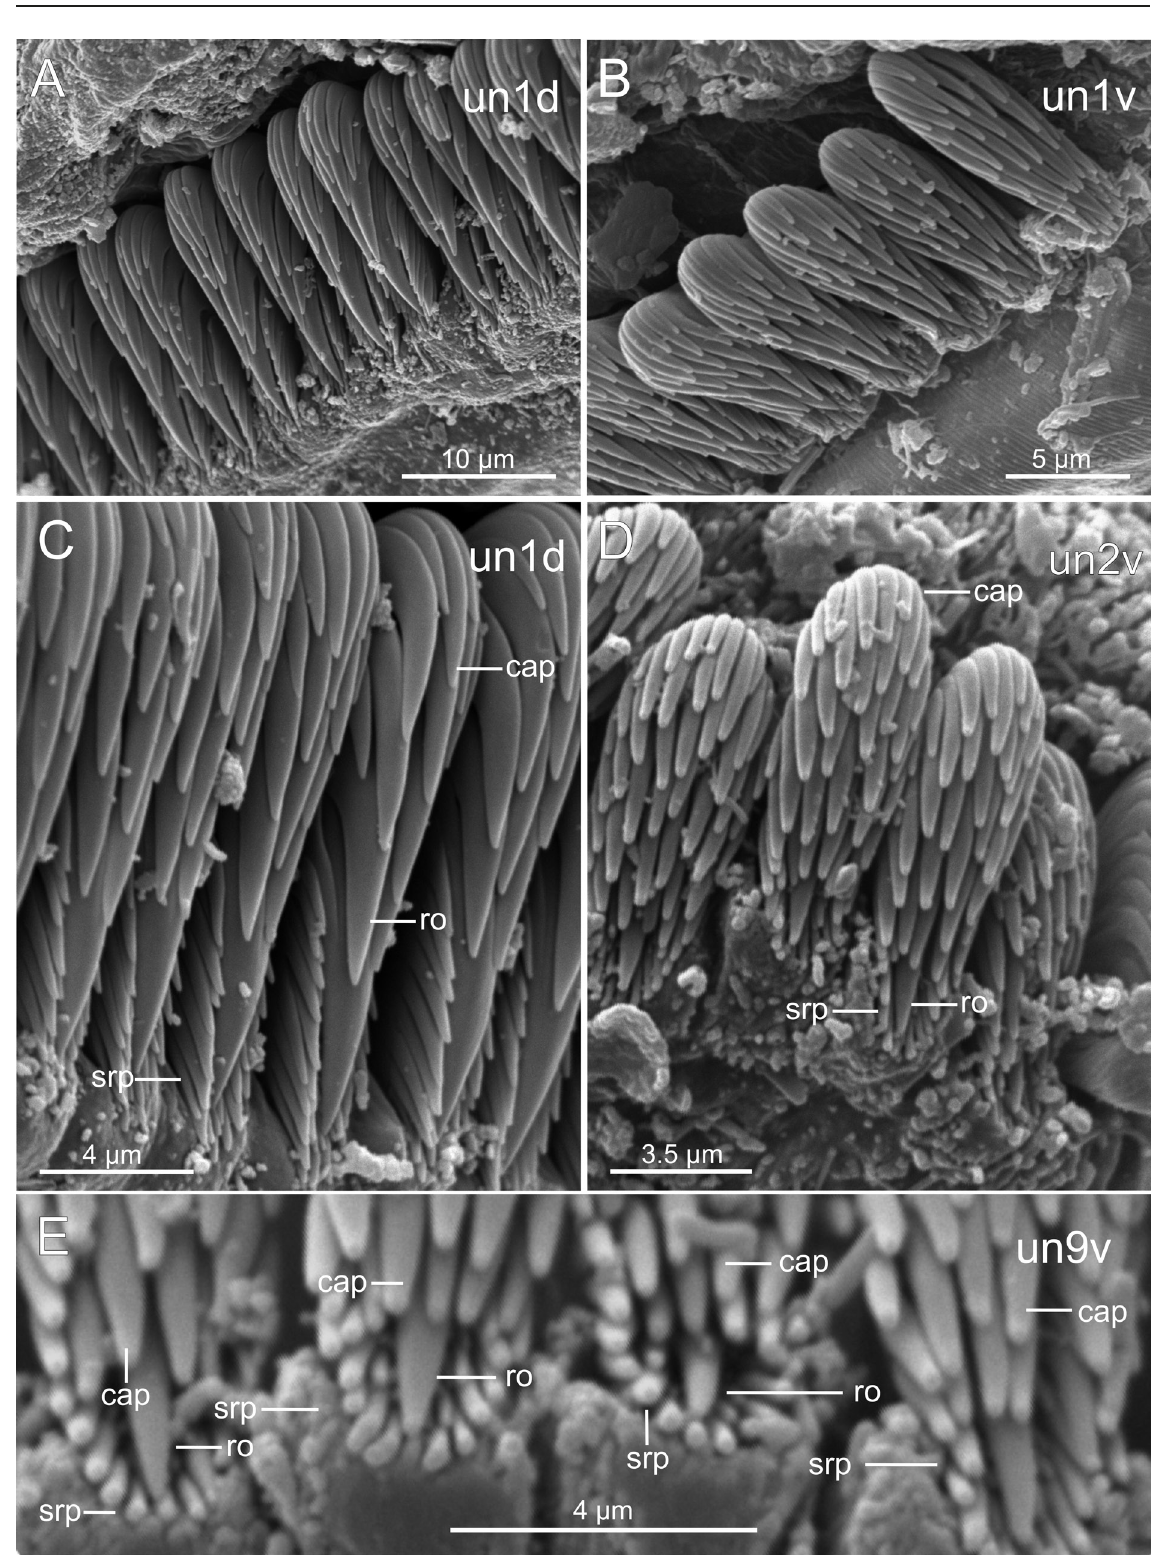
Fig. 7. Amphictene auricoma (O.F. Müller, 1776). SEM micrographs from a small specimen (BIOICE sample 2463, IINH-40481). A–B . Unciniger 1, dorsal and ventral uncini, respectively. C–D . The same in closer view. E . Unciniger 9, ventral uncini, fronto-inferior